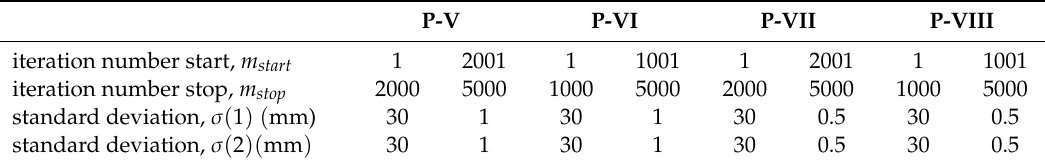
Table 6. Adjusting local stochastic search algorithm by tightening search